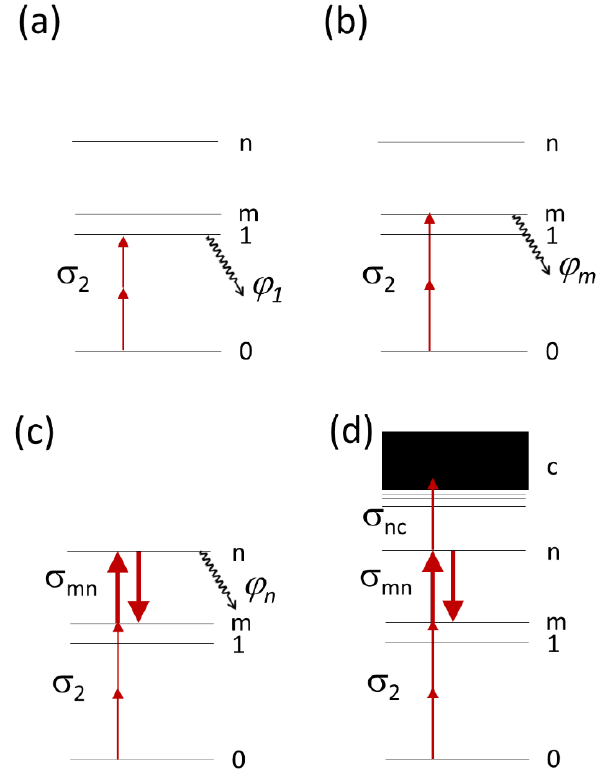
Figure 1. Energy level diagrams for some multiphoton induced photobleaching processes. Panels ( a , b ) correspond to two-photon bleaching following initial two-photon absorption with the cross section σ 2 . Panel ( c ) corresponds to a three-photon bleaching where initial 2P excitation to level m (m can be equal to 1) is followed by a one-photon transition m → n with the 1PA cross section, σ mn . The bold arrows connecting m and n states designate strong absorption (up) and stimulated emission (down) resulting in possible saturation of the m → n transition. Panel ( d ) shows a four-photon bleaching process, where, after three-photon excitation to level n, an electron leaves a molecule with photoionization (photodetachment) cross section σ nc , and transits into a continuum of states ( c ).